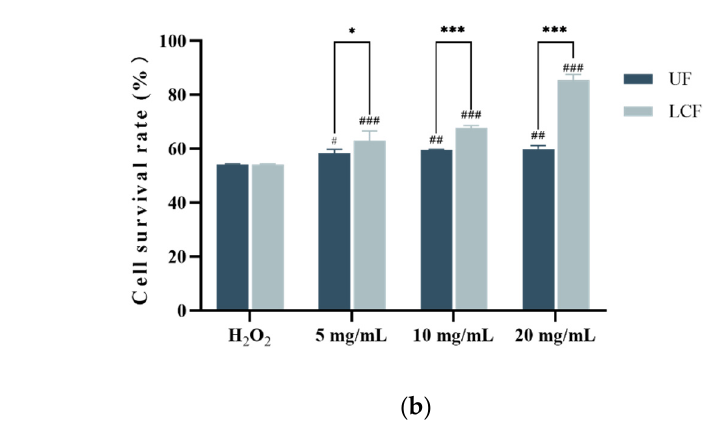
Figure 5. Effects of UF and LCF on HSF cell viability: ( a ) cytotoxicity of UF and LCF; ( b ) protective effects of UF and LCF on H 2 O 2 -damaged HSF; UF: unfermentation; LCF: single microbial fermentation with L. curvatus. Analysis of significant differences between each group and H 2 O 2 model group,